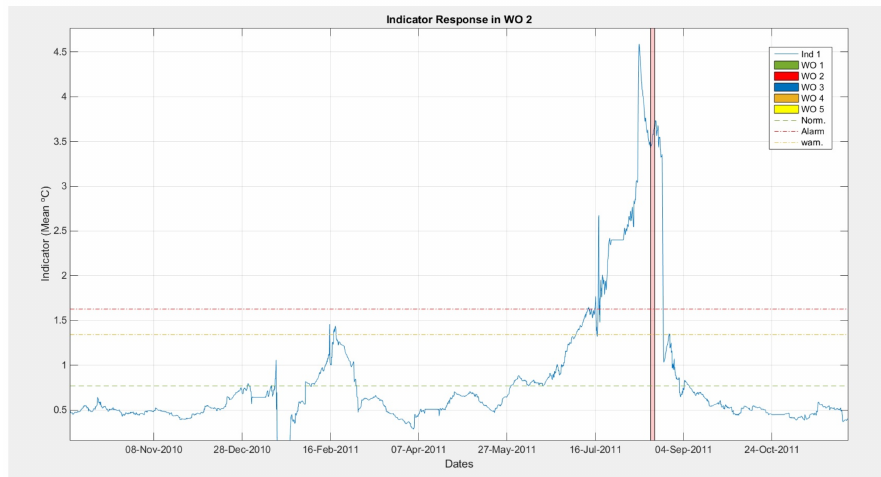
Figure 15. Indicator developed for the complete log.